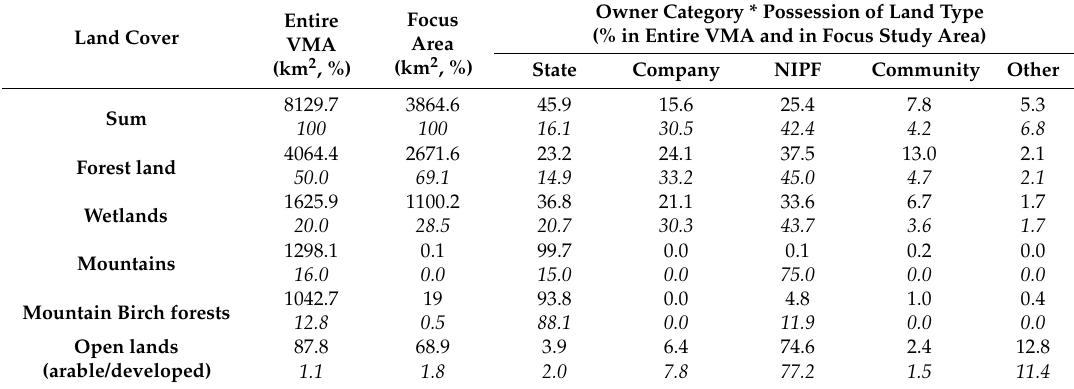
Table 1. Distribution of land cover types (water excluded) for the entire Vilhelmina municipality (entire VMA) of Sweden and our focus study area (focus area) within different forest owner categories. Note that distribution of land between owner categories refers to the situation in January 2016.